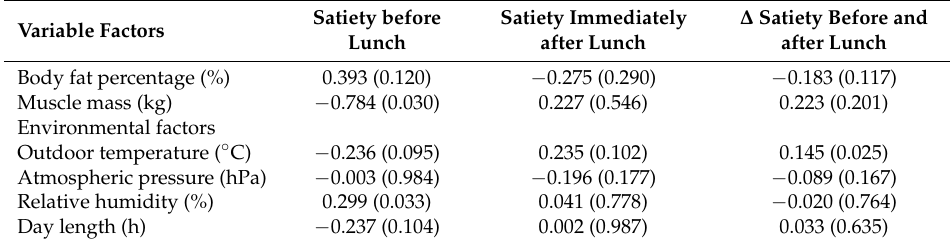
Table 3. Relationships among satiety before and after lunch and various factors.